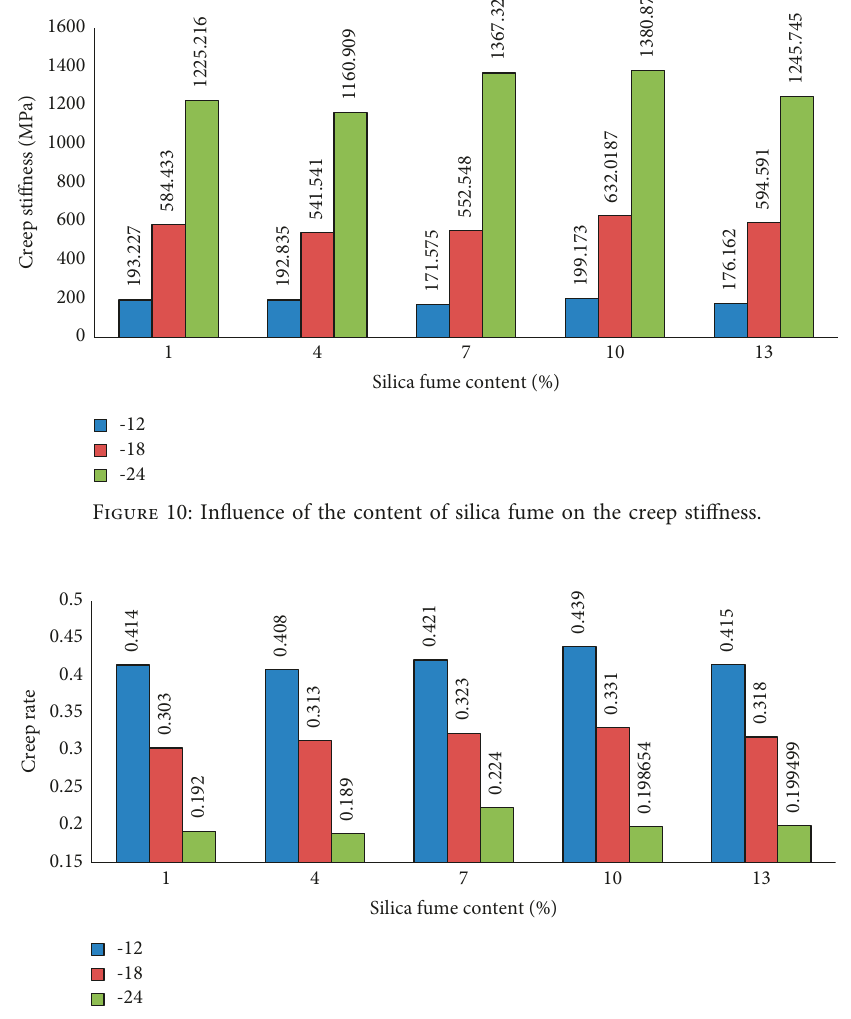
Figure 11: Influence of the content of silica fume on the creep